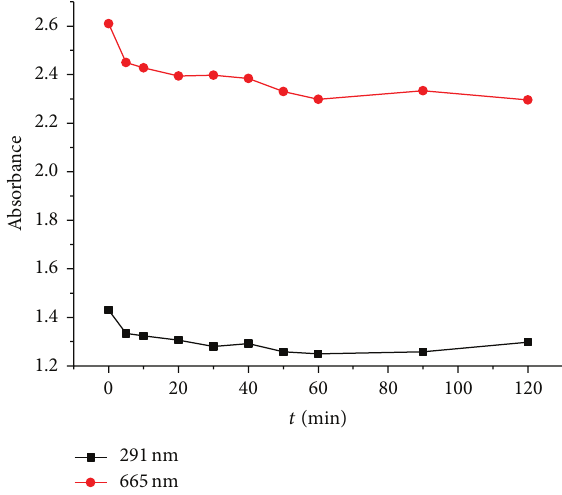
Figure 6: Absorption-time diagram, uncoated glass and no lights. showing reaction rates of 0,0263 min −1 , 0,0215 min −1 , and 0,0210 min −1 , respectively (Figure 12).